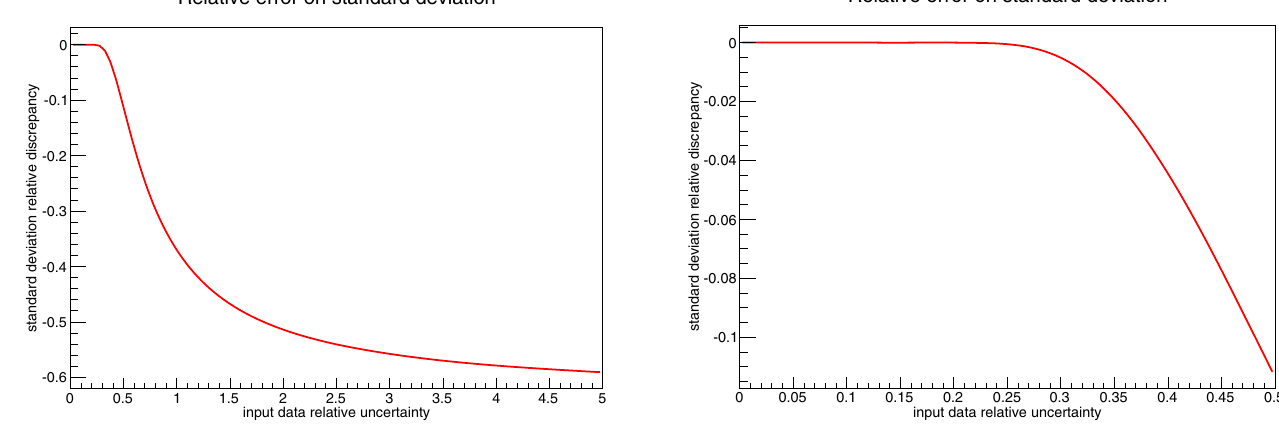
Fig. 3. Relative error on standard deviation value.